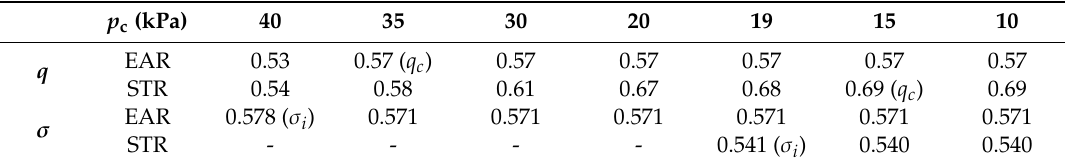
Table 3. Comparison of q c and σ i .